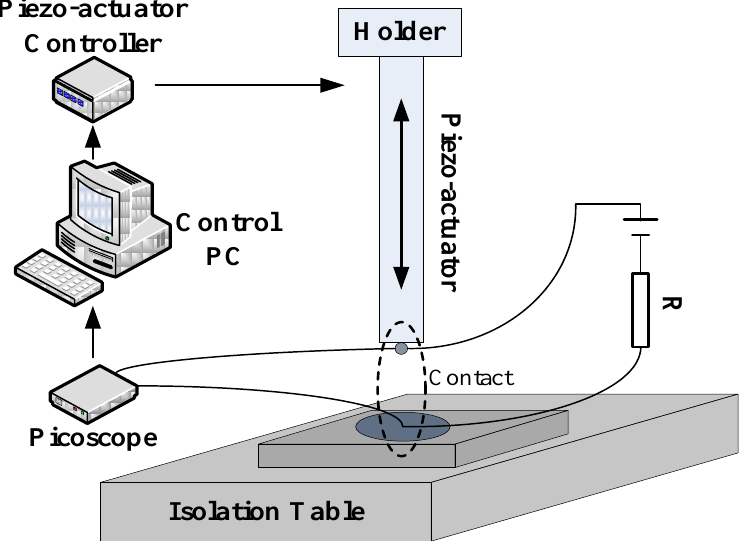
Figure 2. Schematic layout of the experimental